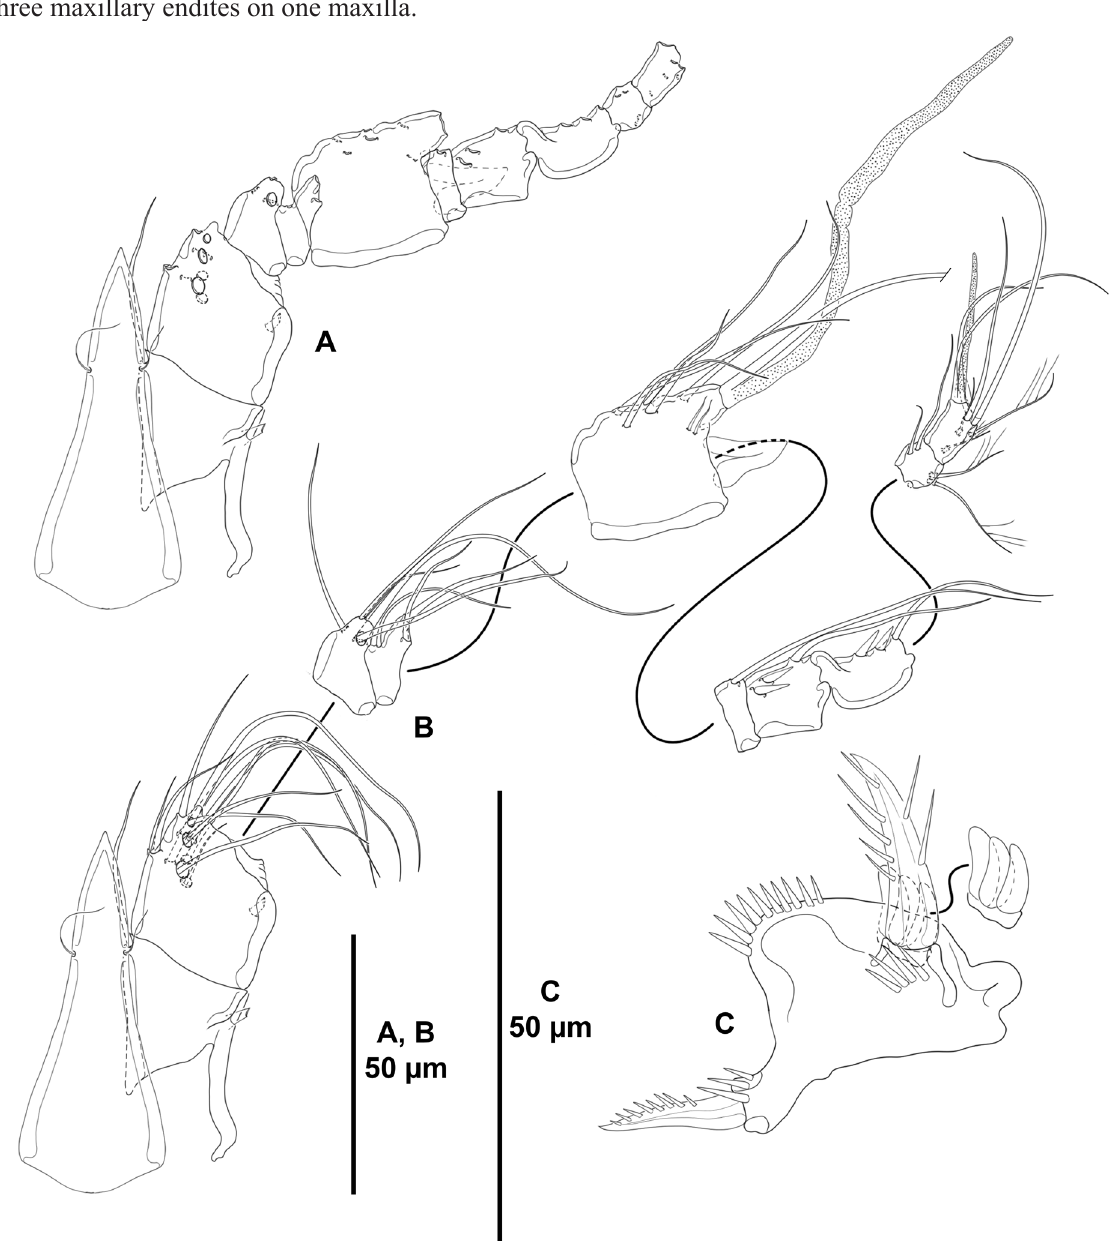
Fig. 9. Typhlamphiascus medici sp. nov., paratype, ♂ (ICML-EMUCOP-180119-44). A . Rostrum and antennule (armature omitted for simplicity). B . Rostrum and antennule showing armature. C. P1 basis, anterior